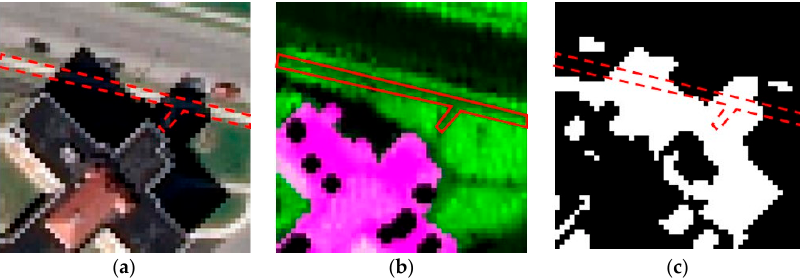
Figure 10. The spatial correspondence for the shadow areas between multi-temporal LiDAR data and the high-resolution image: ( a ) high-resolution image; ( b ) LiDAR data; and, ( c ) mask for shadow areas. The red rectangle indicates the schematic object from the LiDAR data.